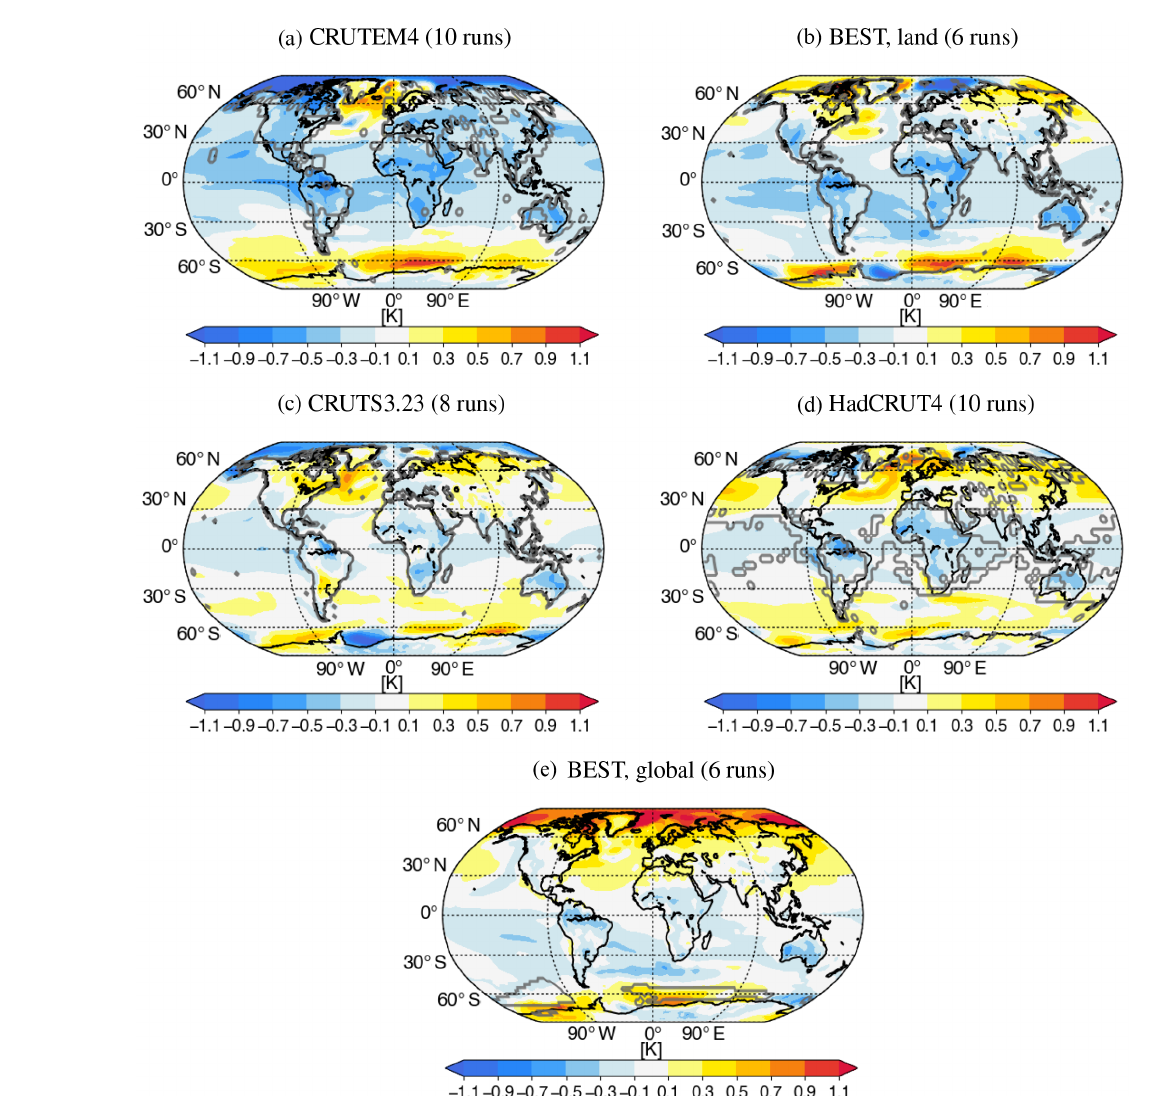
Figure 7. The difference between the multi-model mean (81 runs; first averaged across initial condition members and then averaged across 38 models) and the optimal subset is shown for the RCP8.5 surface air temperature change between (2081–2100) and (1986–2005). The optimal subset is different depending on which observational product is used. The grey contours outline the region which was used to obtain the optimal subset in the historical period. The optimal ensemble size for each observational product is given in the title of each